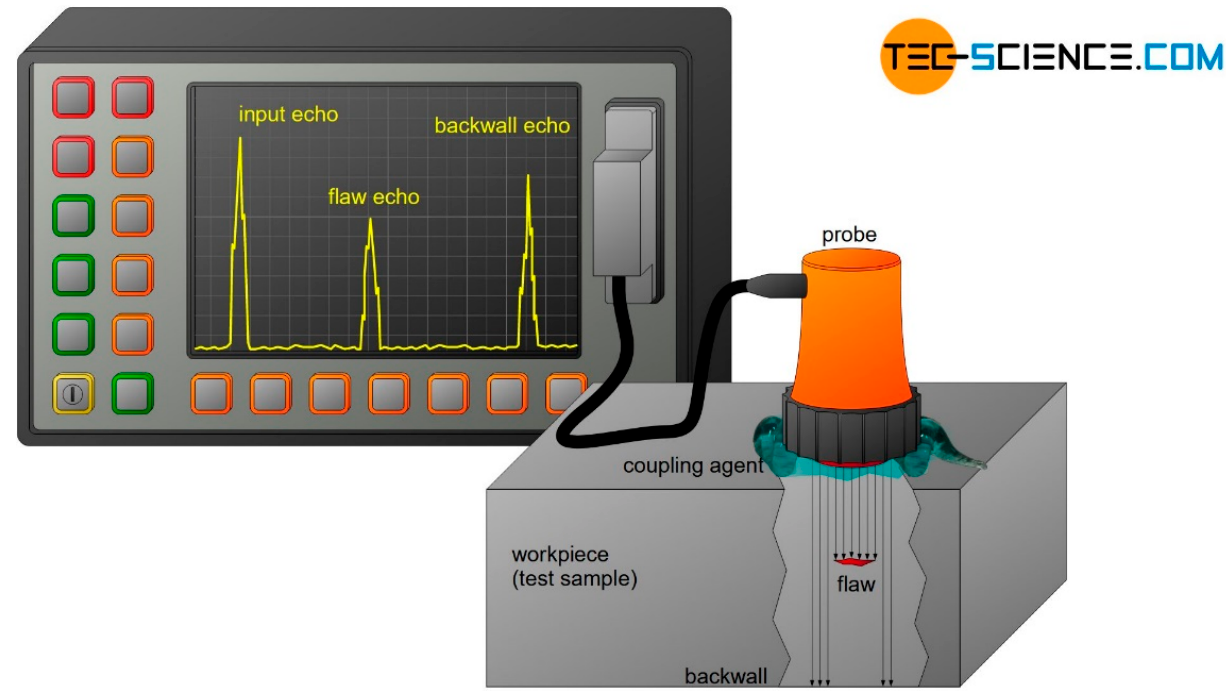
Figure 7. Principle of ultrasonic testing [101]. Figure 7.